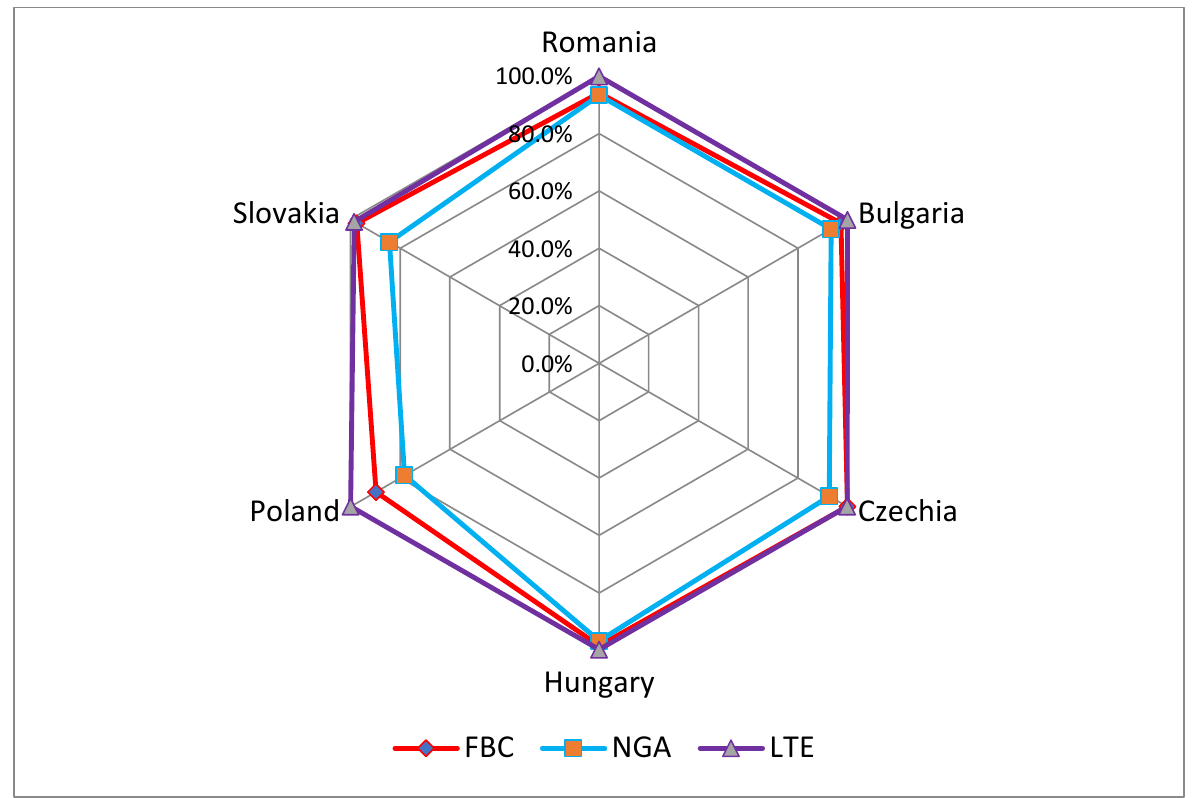
Figure 2. Broadband networks coverage in 2021.